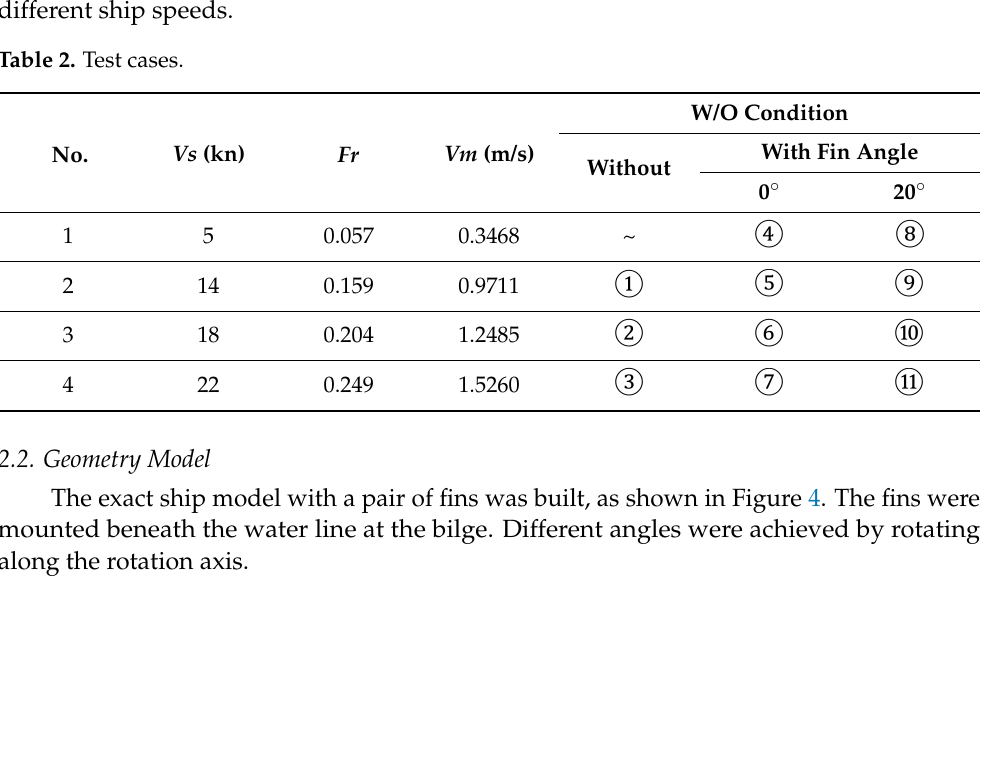
Figure 3. Display of ship model with fins. ( a ) The whole model. ( b ) Fin at port side. ( c ) Hydrofoil section of the fin.